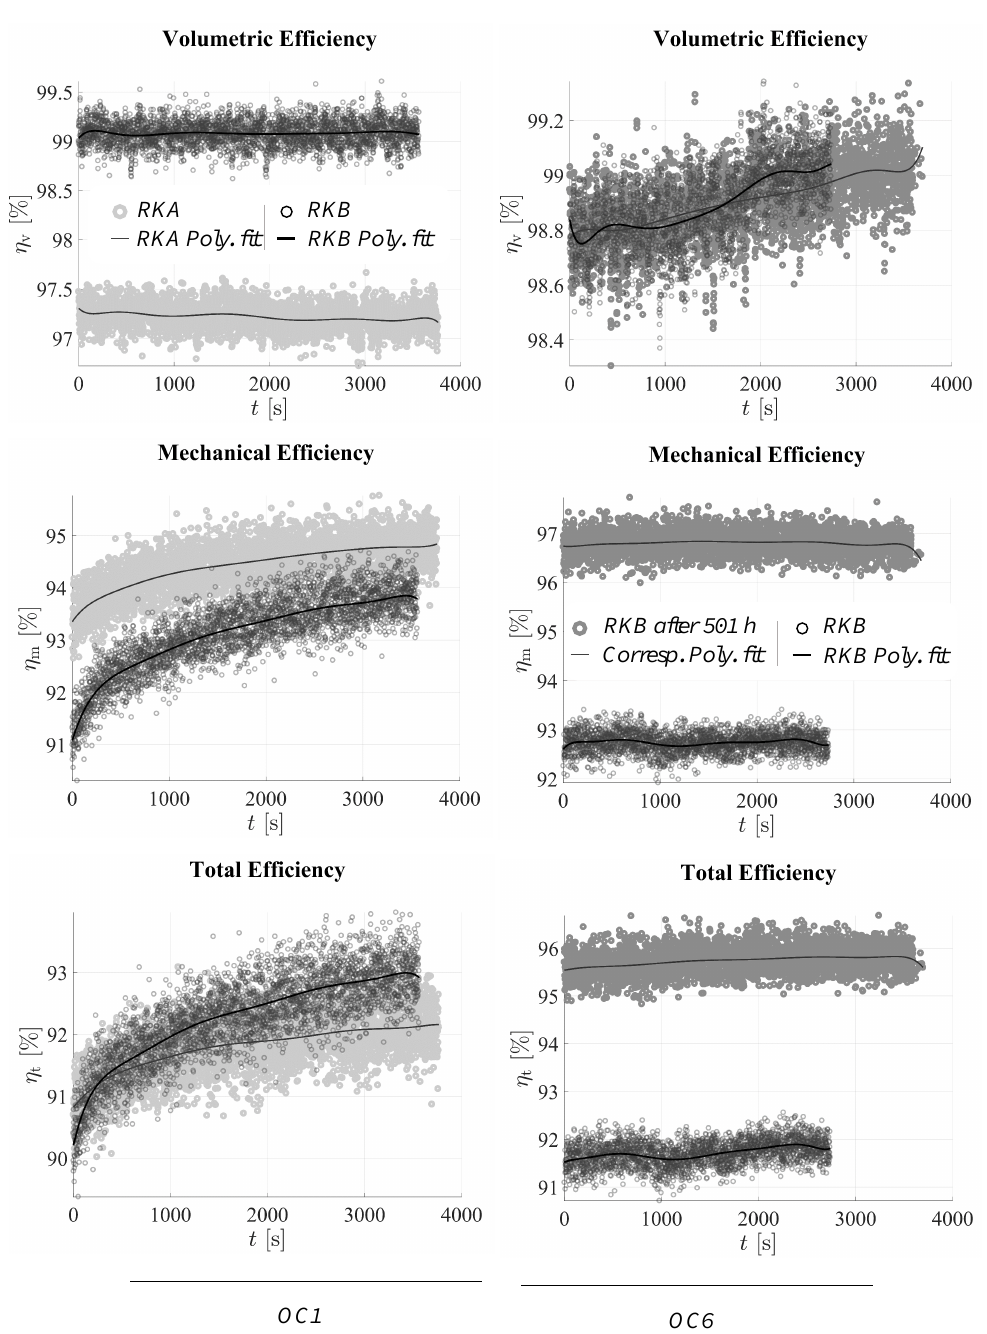
Figure 19. Measured efficiency for OC1 and